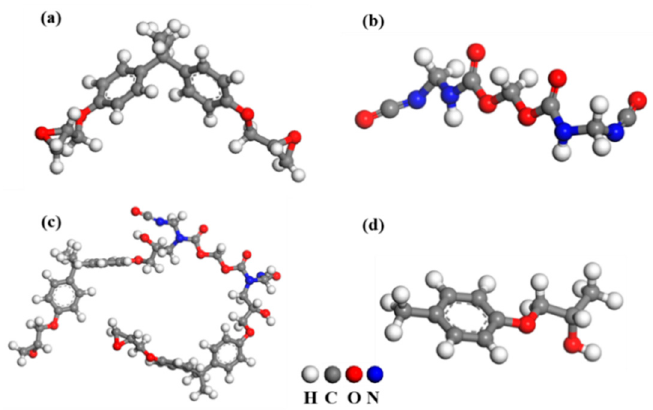
Figure 2. Optimized geometries of the monomer of ( a ) DGEBA, ( b ) MUPR, and ( c ) MUPR-modified DGEBA in MD simulation, and ( d ) DGEBA segment in DFT calculation [16,28,29]. A DGEBA molecule segment was used as the adhesive model in DFT calculations, as shown in Figure 2d. Supercells of ZnO (10-10), Al 2 O 3 (100), and MgO (100) with 128, 120, and 120 atoms, respectively, and a vacuum layer thickness of 15 Å were placed above the oxide surfaces. The final dimensions of the ZnO (10-10), Al 2 O 3 (100), and MgO (100) super- cells were 13.0 Å × 10.4 Å × 24.4 Å, 12.6 Å × 8.4 Å × 23.4 Å, and 11.2 Å × 8.4 Å × 26.3